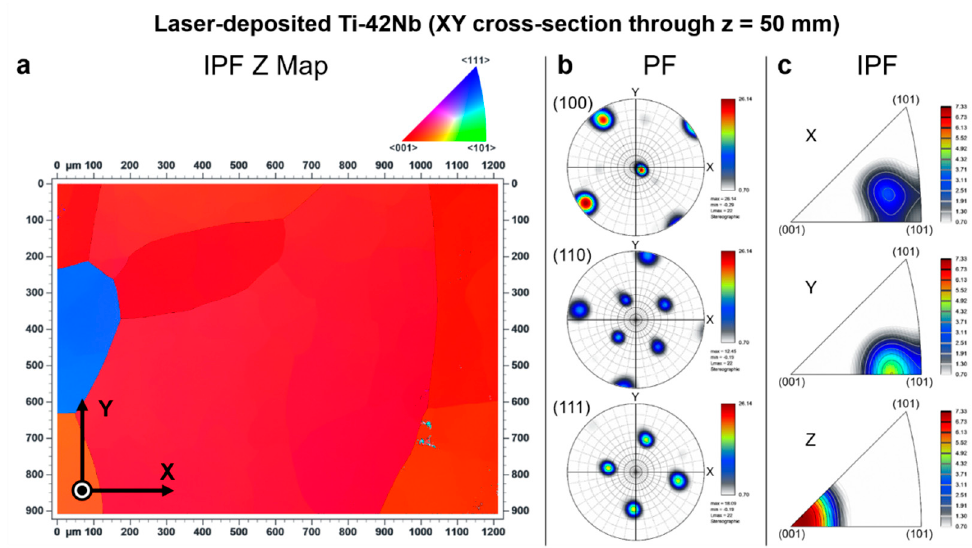
Figure 8. Electron backscatter diffraction (EBSD) results at XY cross-section through z = 50 mm: ( a ) inverse pole figure Z map (IPF Z Map), ( b ) pole figures (PF), and ( c ) inverse pole figures (IPF).